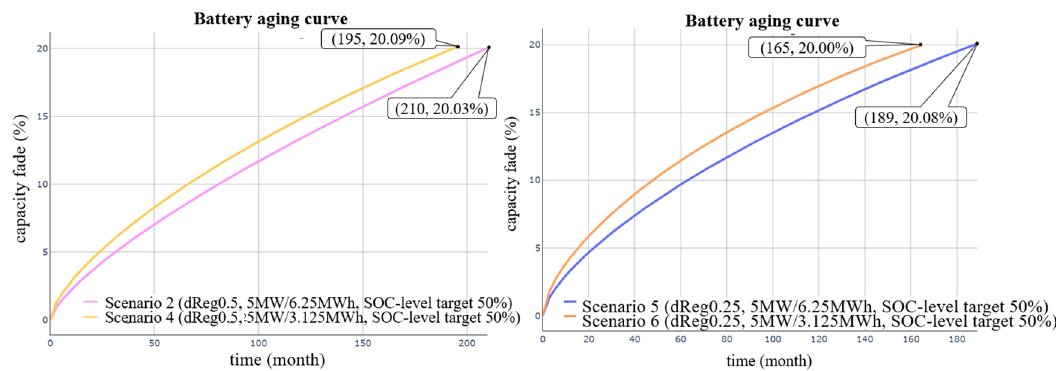
Figure 15. The result under different C-rates using dReg0.5 and dReg0.25.